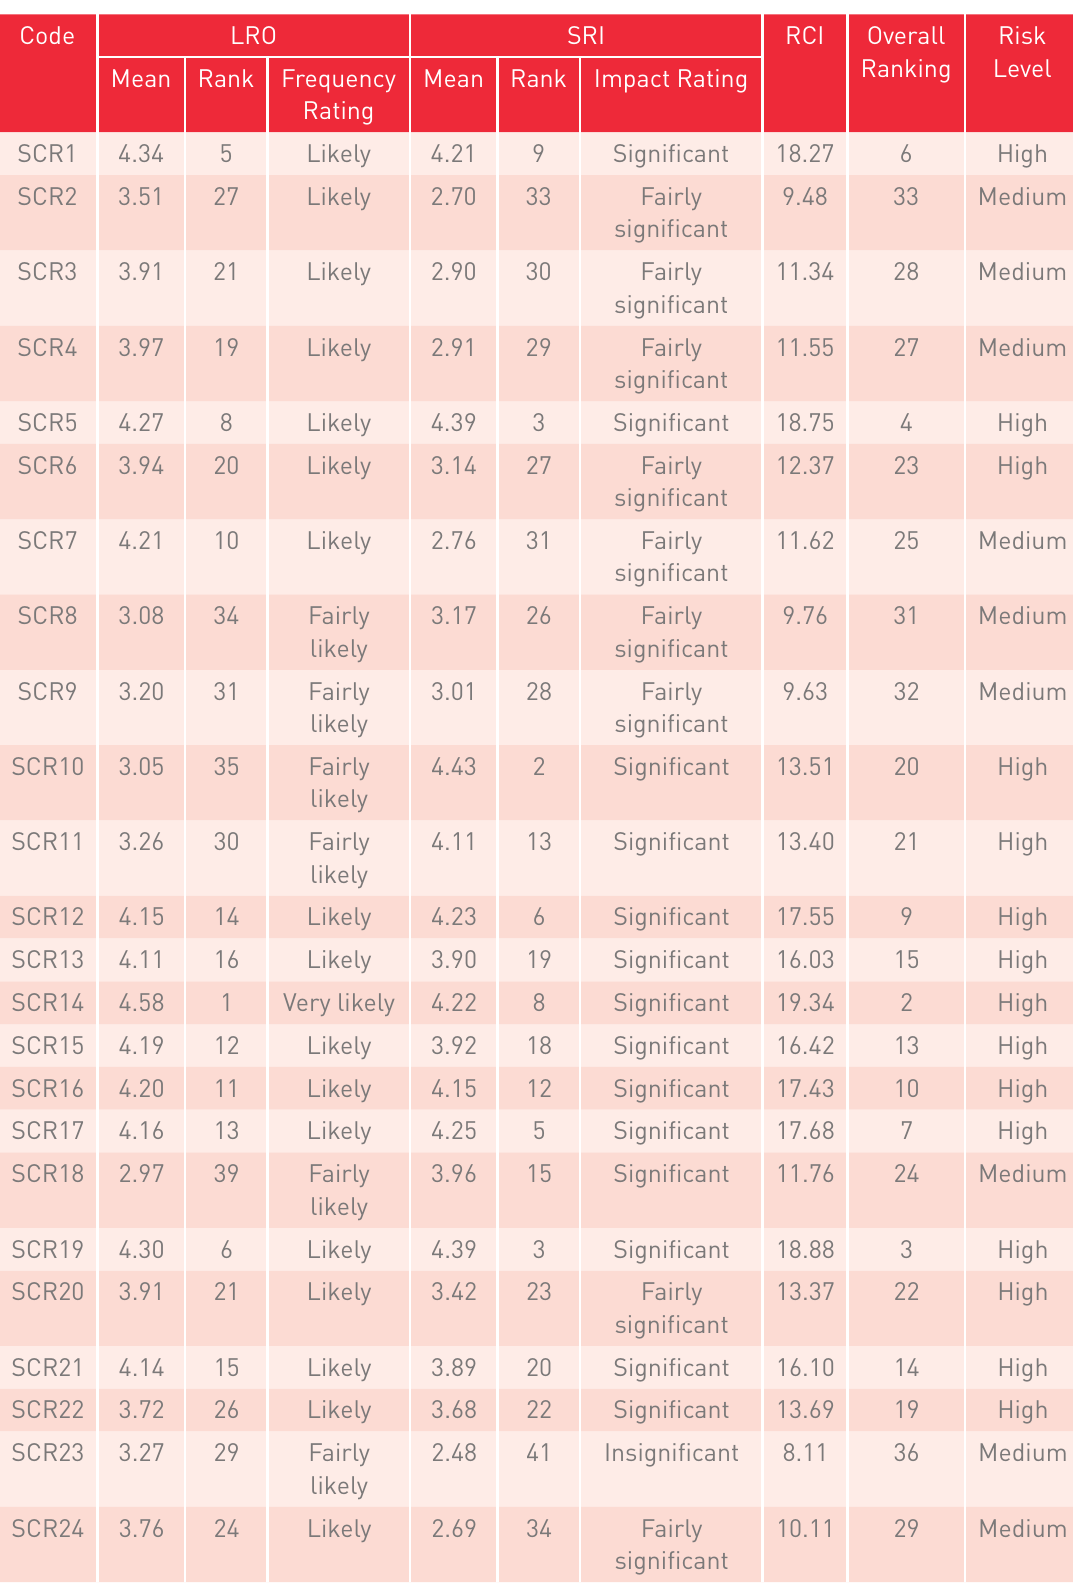
Table 4. Assessment of risks associated with implementation of sustainable construction